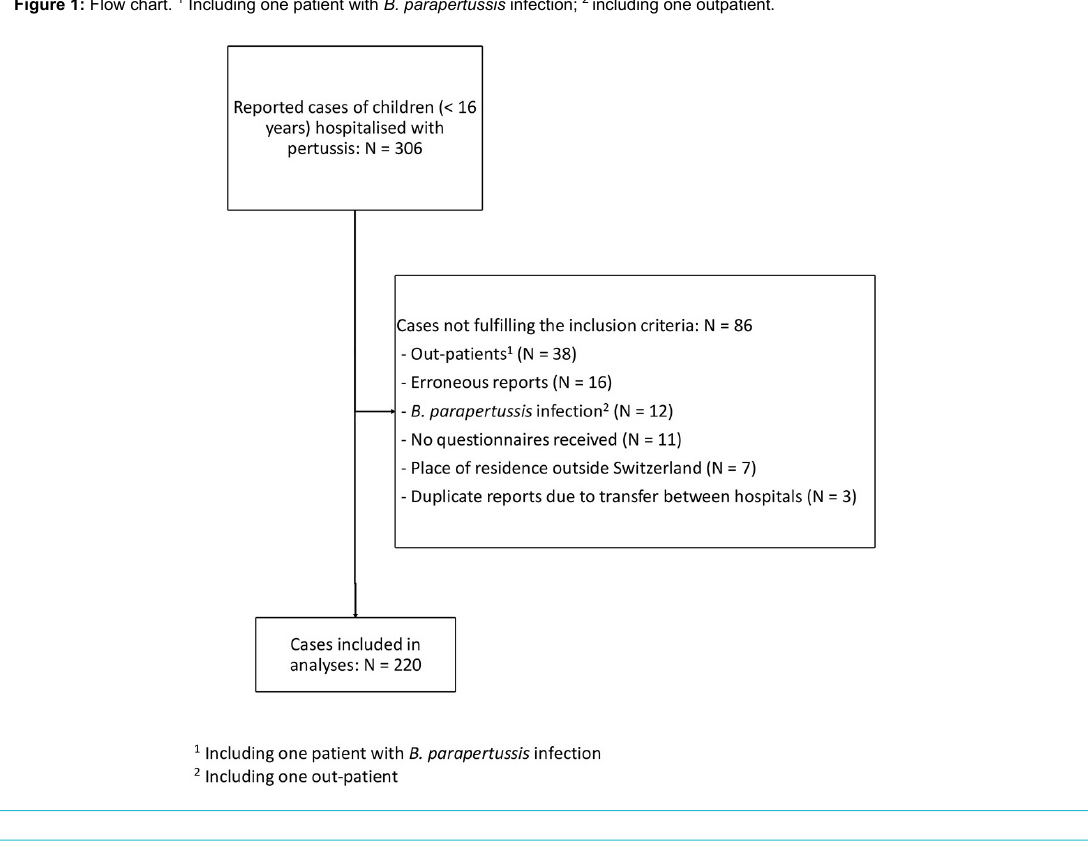
Figure 1: Flow chart. 1 Including one patient with B. parapertussis infection; 2 including one outpatient.